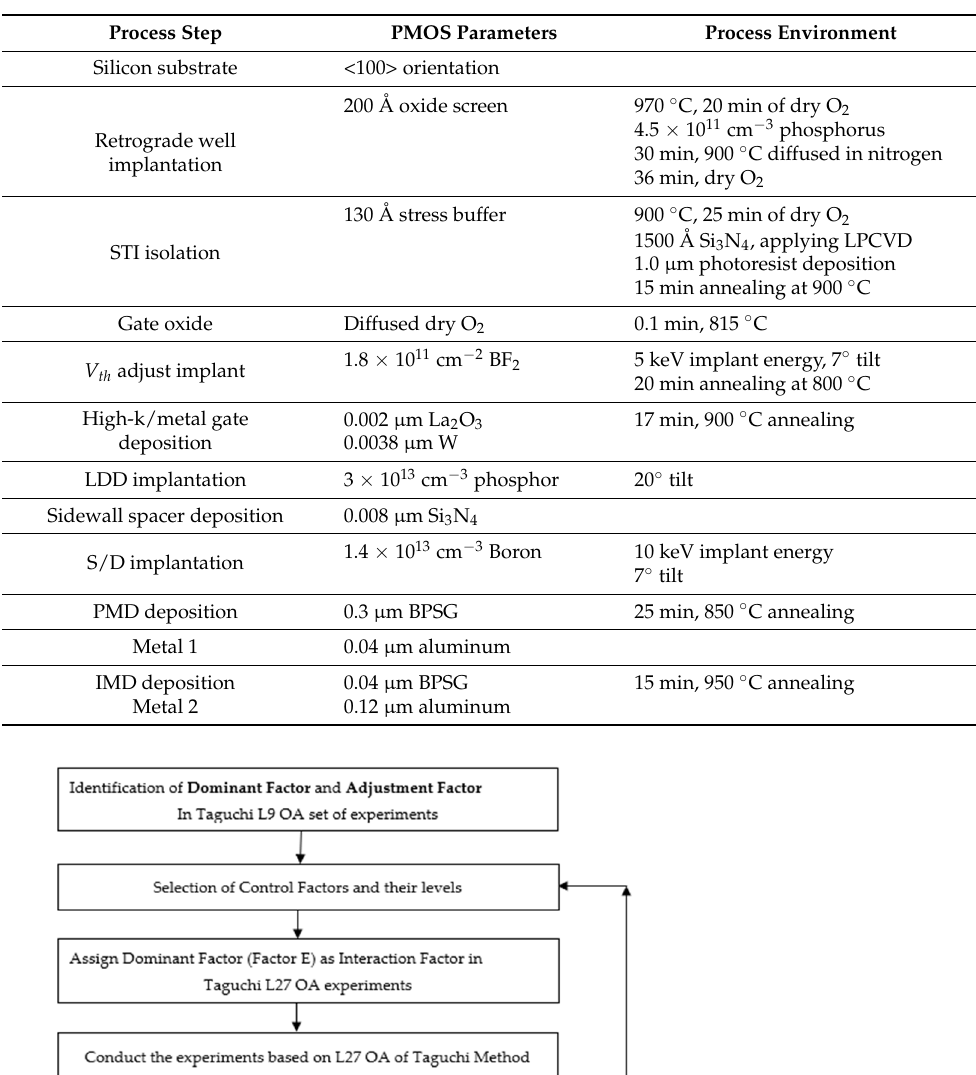
Table 1. PMOS fabrication design.